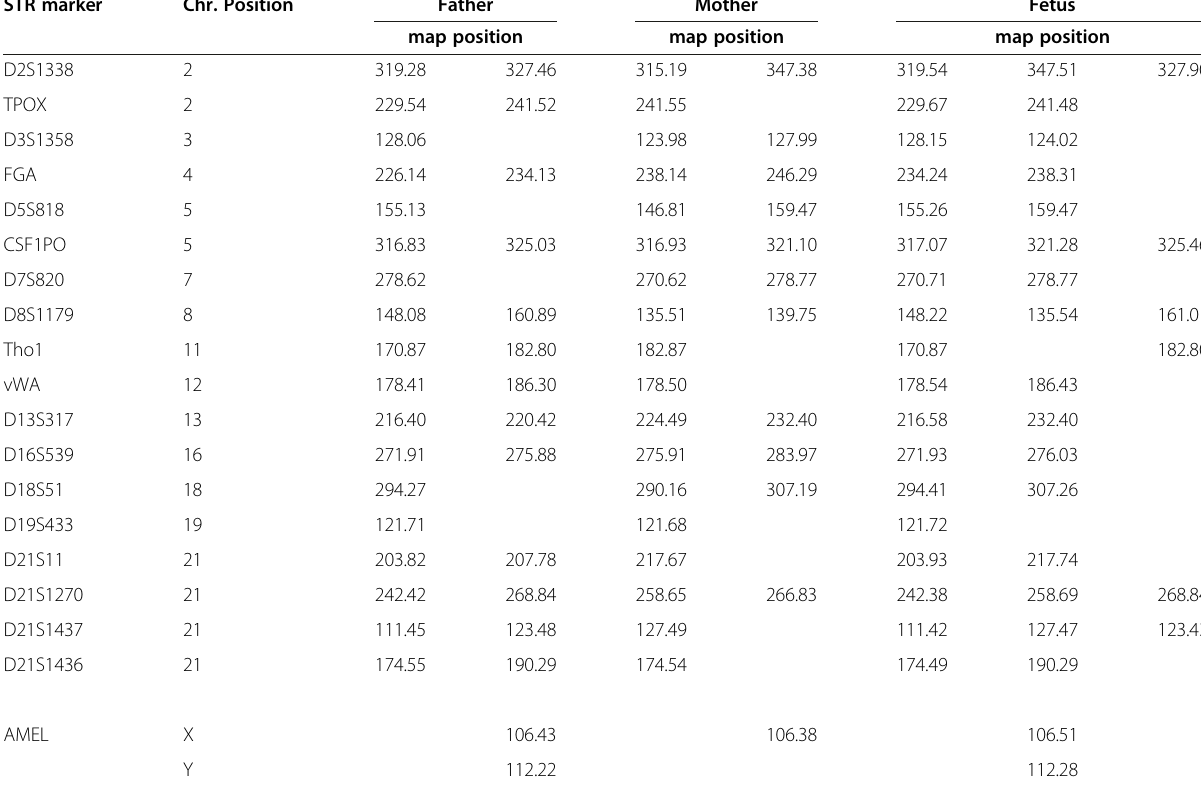
Table 1 Chromosome map position for STR markers used in the present report STR marker Chr. Position